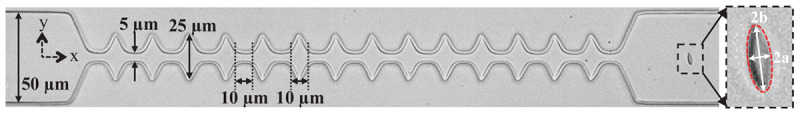
The geometry consists in a 50 μm wide channel implementing 14 tooth-like patterns. The height of the device is 10 μm. The different dimensions are reported on the pictures. The inset shows a close-up of a RBC which contour is fitted by an ellipse (dashed red line). The two axes of the ellipse along (2a) and perpendicular (2b) to the flow direction allows the calculation of a deformation index such as D = (2a–2b)/(2a + 2b).